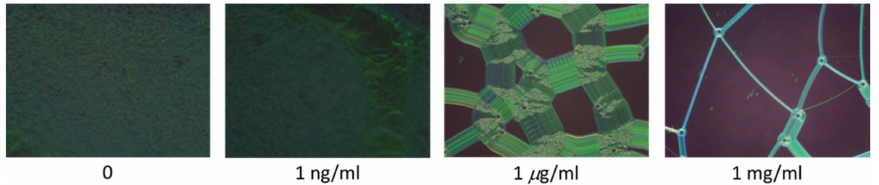
Figure 3. Polarized optical microscopic images captured by the CLC test kit operated by a smartphone under various concentrations of cTnI (0–1 mg/mL) immobilized on DMOAP-coated